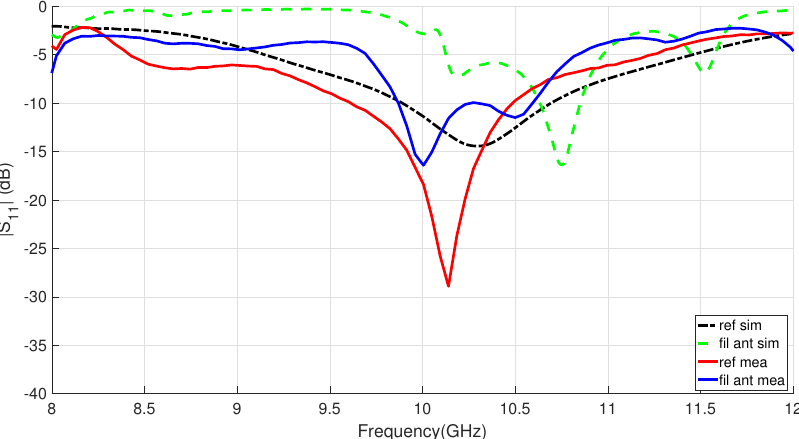
Figure 19. Measured and simulated frequency response | S 11 | of the proposed IM-GWG filtering antenna compared to the reference slot